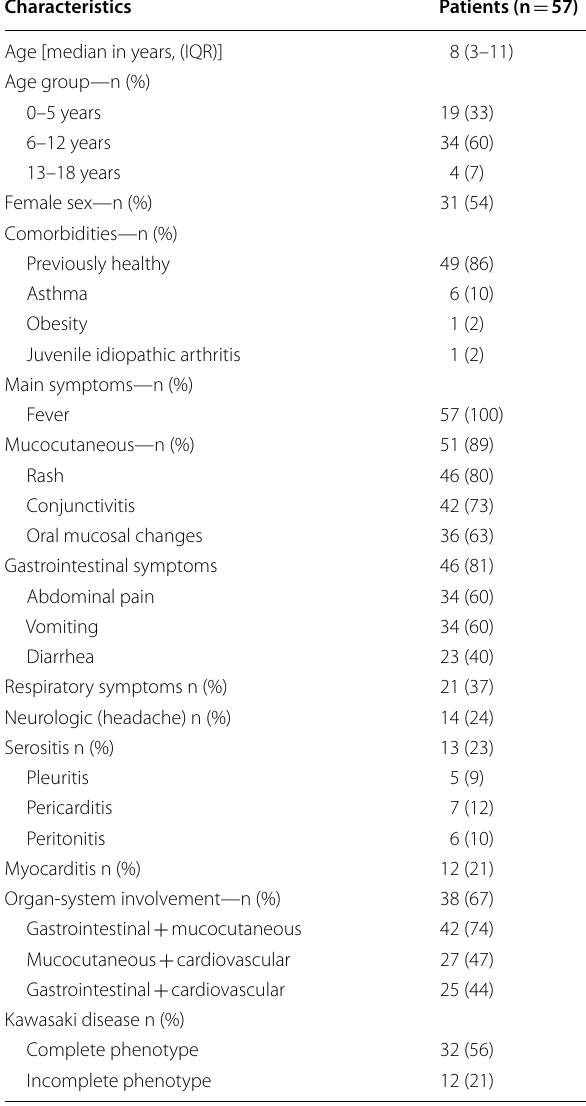
Table 1 Clinical and demographic features of patients with paediatric inflammatory multisystem syndrome temporally associated with